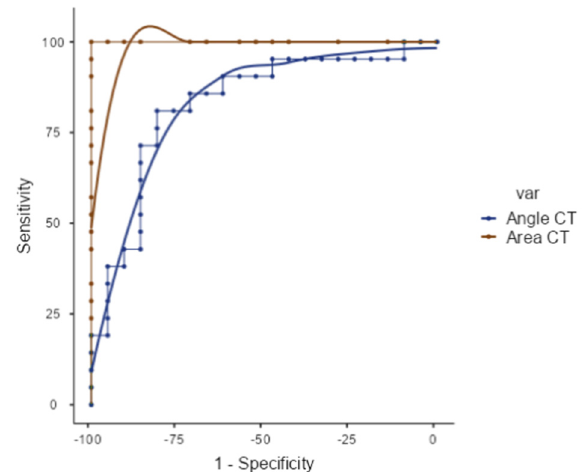
Table 2. The Sensitivity and Specificity cutoff values of the Alveolar space area (ASA) as estimated by the Computer Tool (CT).